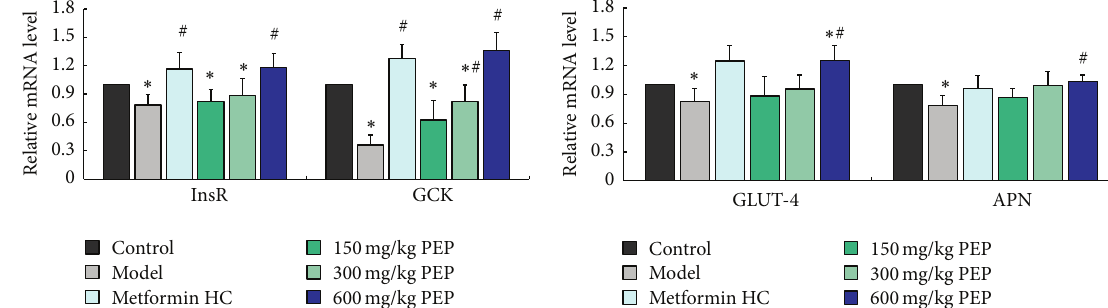
Figure 5: The effect of PEP on the mRNA expression of GCK and InsR in the liver and APN and GLUT-4 in adipose tissue in DM rats. A DM model was established by feeding rats a high-fat diet and injecting them with a low dose of STZ. After the model was established, PEP (0, 150, 300, and 600 mg/kg) was administered intragastrically as an intervention for 28 d. Subsequently, liver and adipose tissue was collected; mRNA was extracted, reverse transcribed into cDNA, and analyzed by real-time PCR to determine the mRNA expression levels in the rats in each group. The mRNA expression levels were determined using the relative quantification method ( 𝛽 -actin was used as the internal control). The data are presented as the mean ± standard deviation ( 𝑛 = 10 rats). Compared with the control group: ∗ 𝑃 < 0.05 ; compared with the model group: # 𝑃 < 0.05